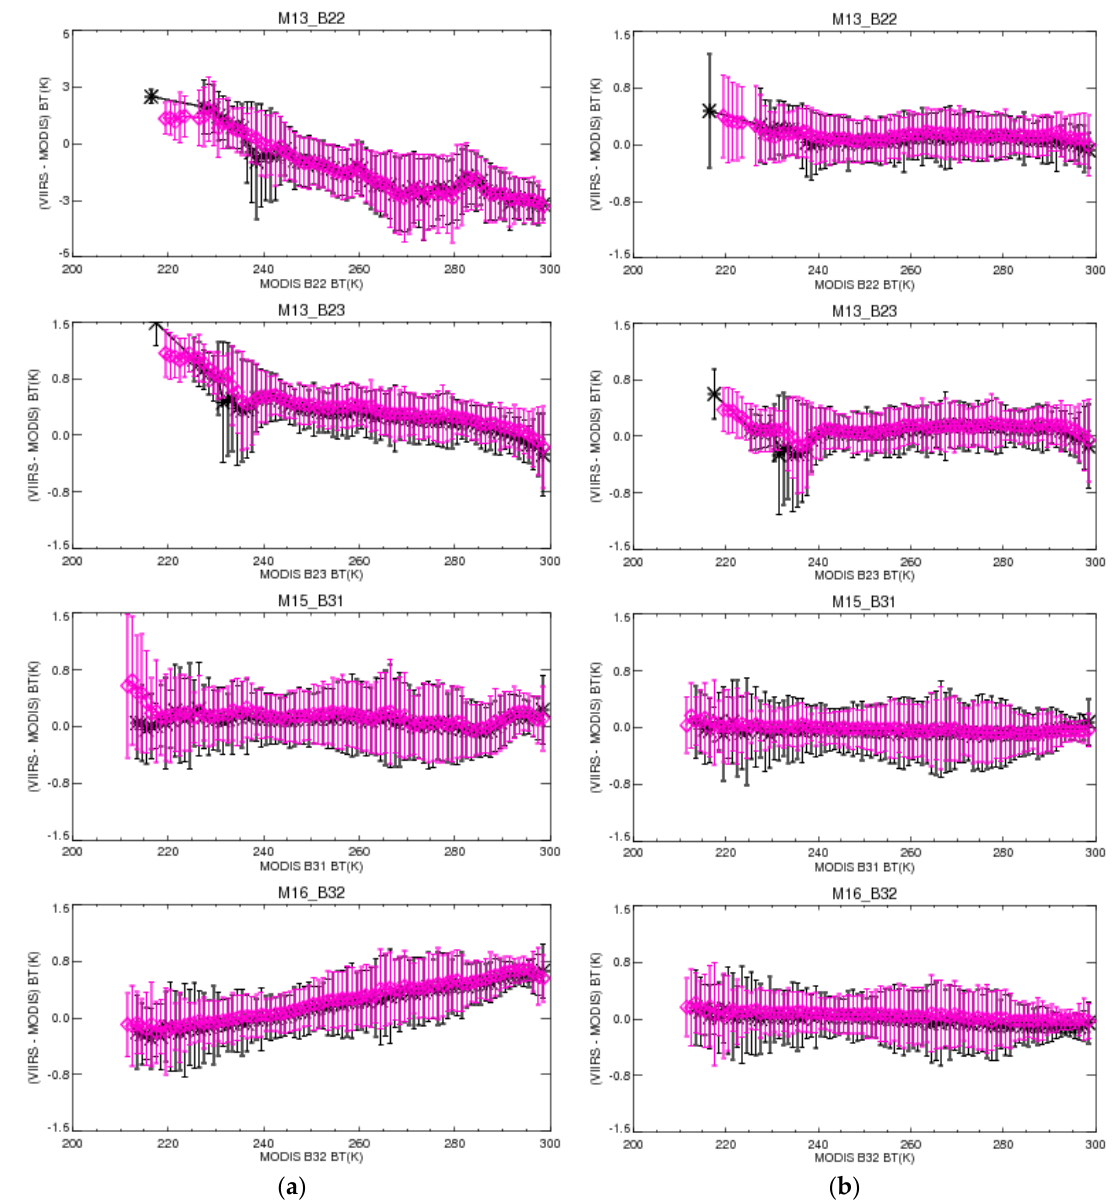
Figure 4. VIIRS-MODIS inter-comparison without/with RSR correction from AIRS (black stars) and CrIS (blue diamonds) measurements, ( a ) without RSR correction; and ( b ) with RSR correction.